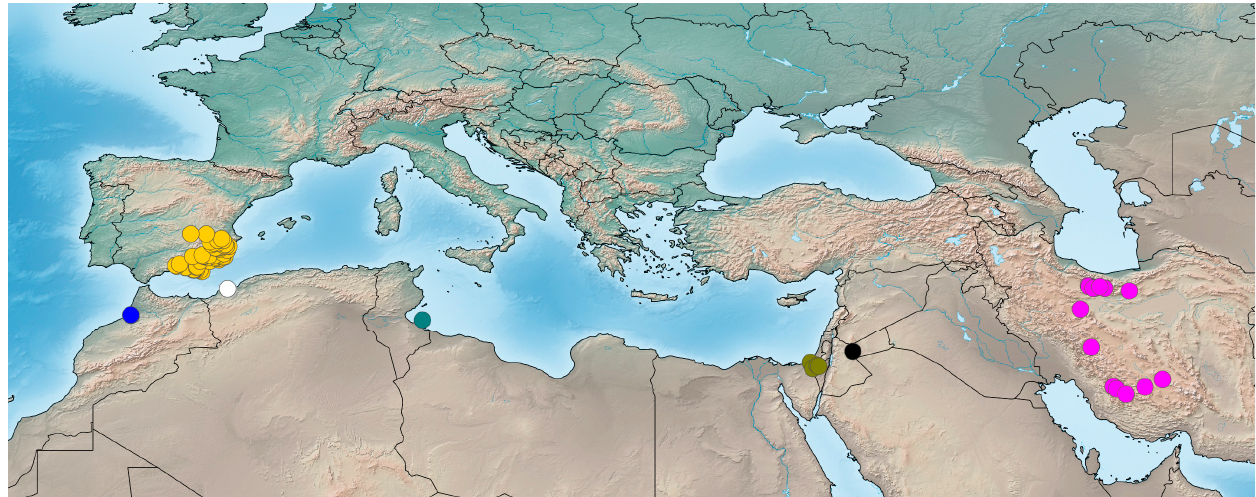
Figure 5. Distribution records of species of Loureedia . Color codes: yellow— L. colleni , blue— L. maroccana , white— L. lucasi , green— L. jerbae , khaki— L. annulipes ( SAJ264 not shown), magenta— L. phoenixi , black dot—unidentified Loureedia specimen from Jordan